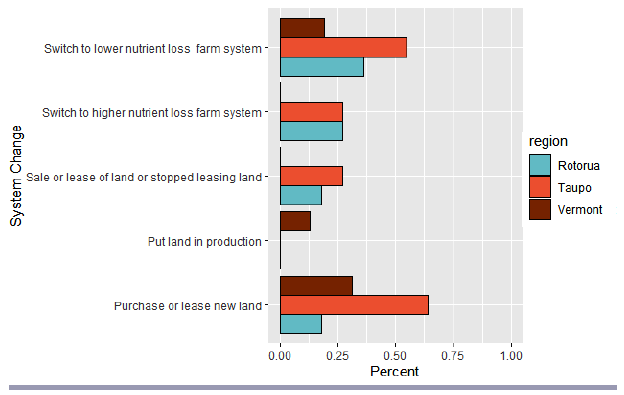
Fig. 4 . Percentage of sample reporting system changes by